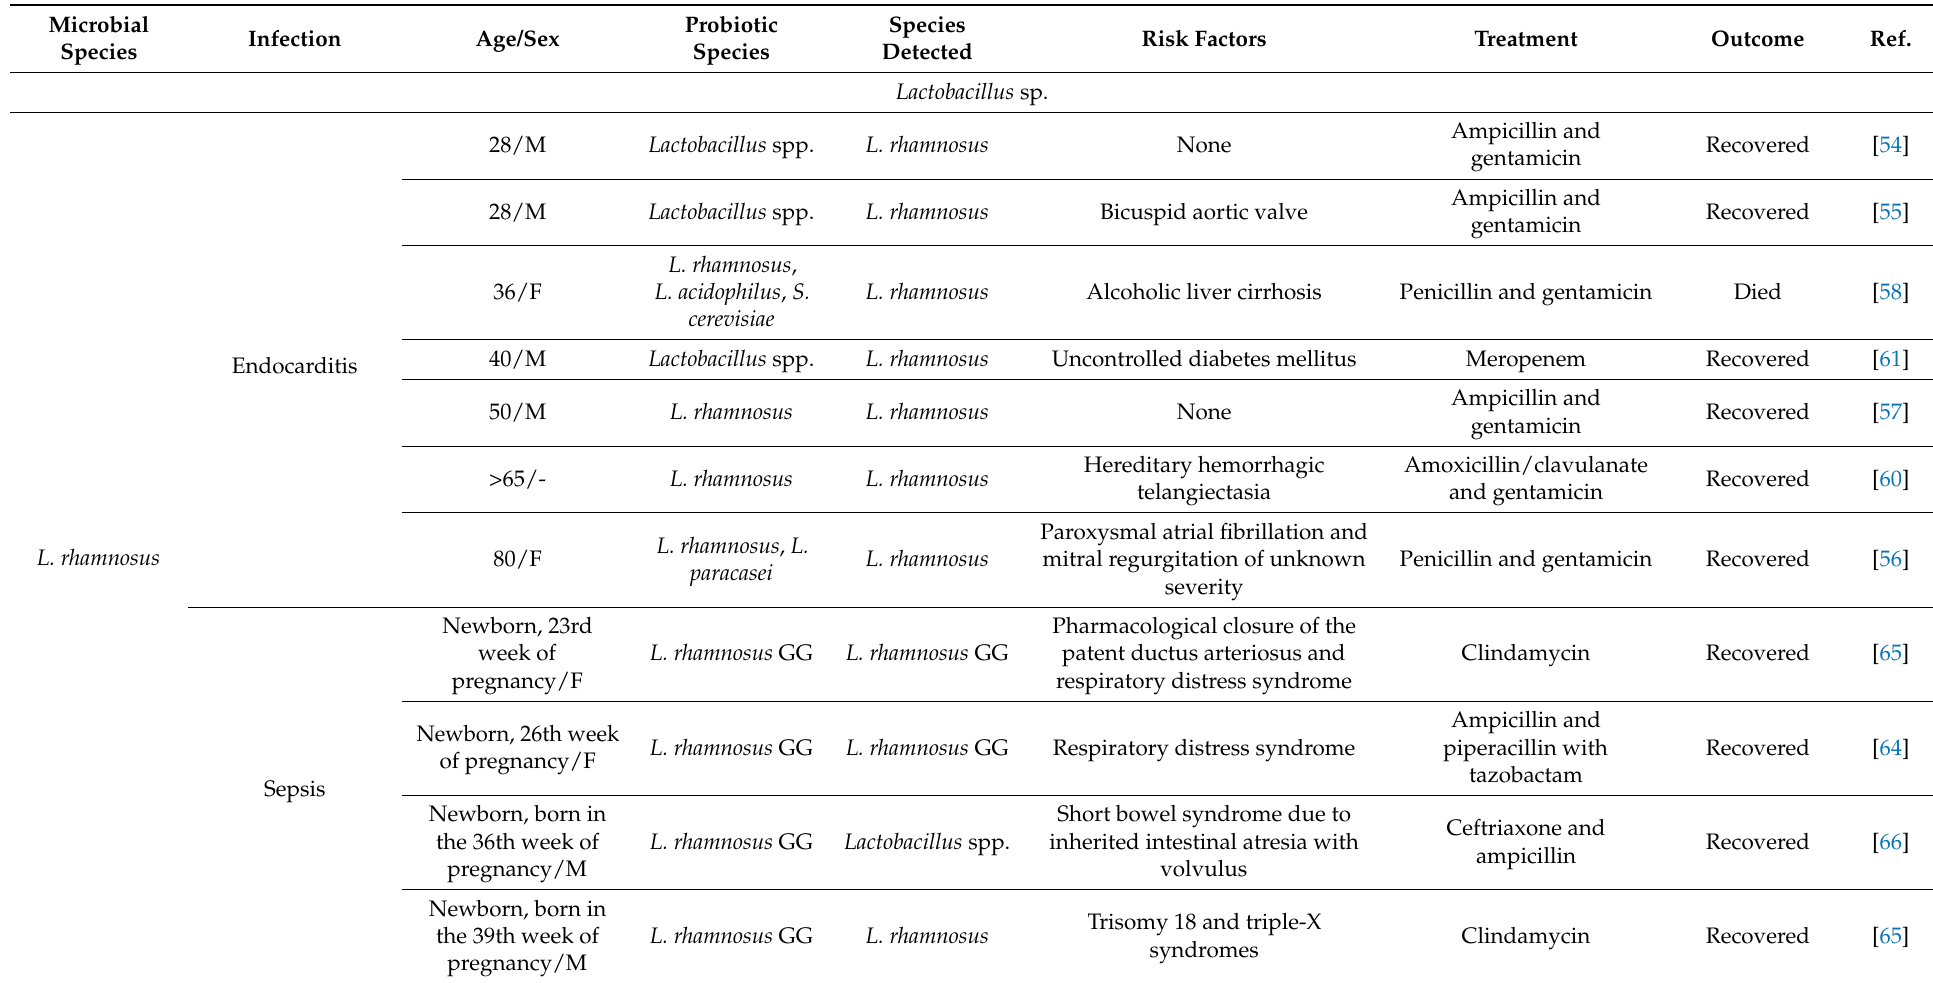
Table 1. Summary of the reviewed cases of infections associated with probiotics